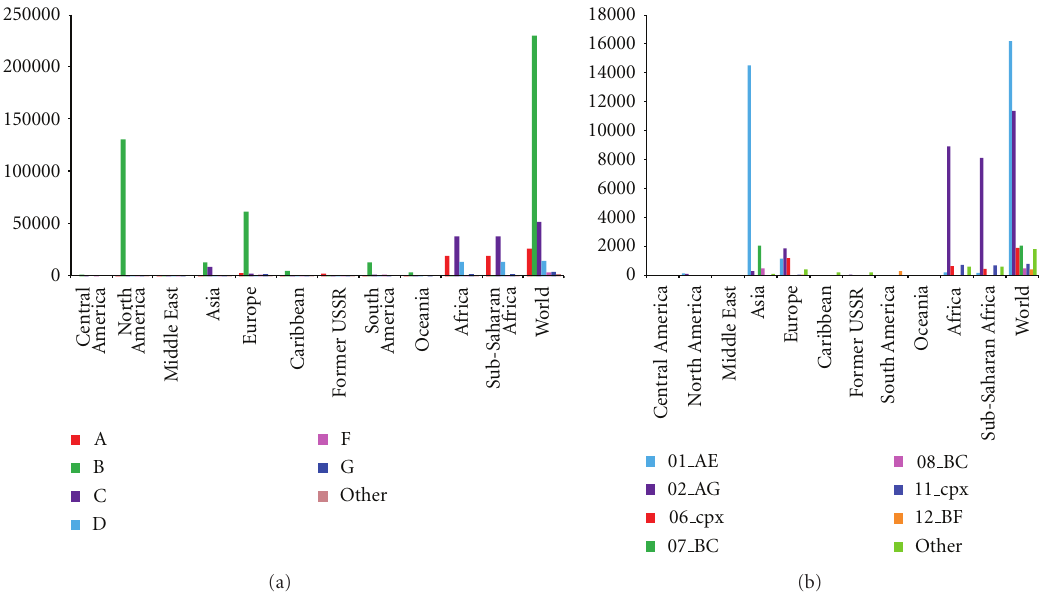
Figure 1: (a) Global distribution of HIV-1 (nonrecombinants) sequences. (b) Global distribution of recombinant HIV-1 sequences. Source: HIV databases